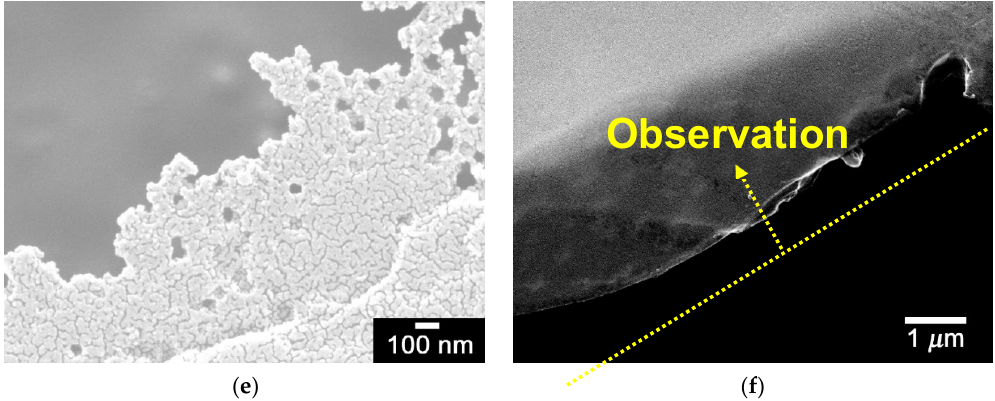
Figure 4. Scanning electron microscopy (SEM) images of V-CB(PANI). ( a ) Surface, ( b ) layer structure (A, sample surface; B, inner layer); ( c,d ) Magnification of the inner layer; ( e ) Holes in the layer; ( f ) Cross-sectional orientation for layer observation of the sample.